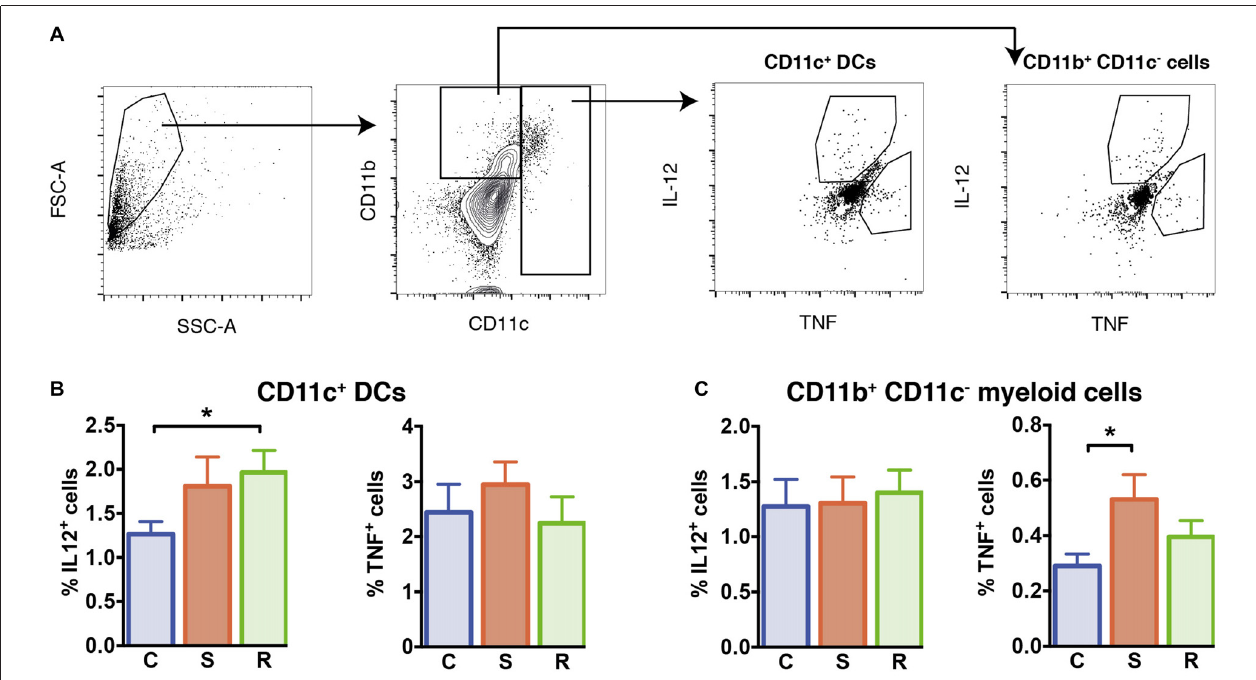
FIGURE 4 | Cytokine production in LPS stimulated isolated splenocytes. (A) Gating of interleukin (IL)-12 + and tumor necrosis factor (TNF) + CD11c + DCs and CD11b + CD11c − myeloid cells. (B) Significantly increased percentages of IL-12 + cells in resilient mice among the CD11c + DCs and similar percentages of TNF + DCs. (C) Similar percentages of IL-12 + cells and increased percentages of TNF + cells among the CD11b + CD11c − myeloid cells in susceptible mice. Bar graphs represent mean + SEM. C, control; S, susceptible; R, resilient. n C = 15, n S = 14, n R = 14. ∗ p <